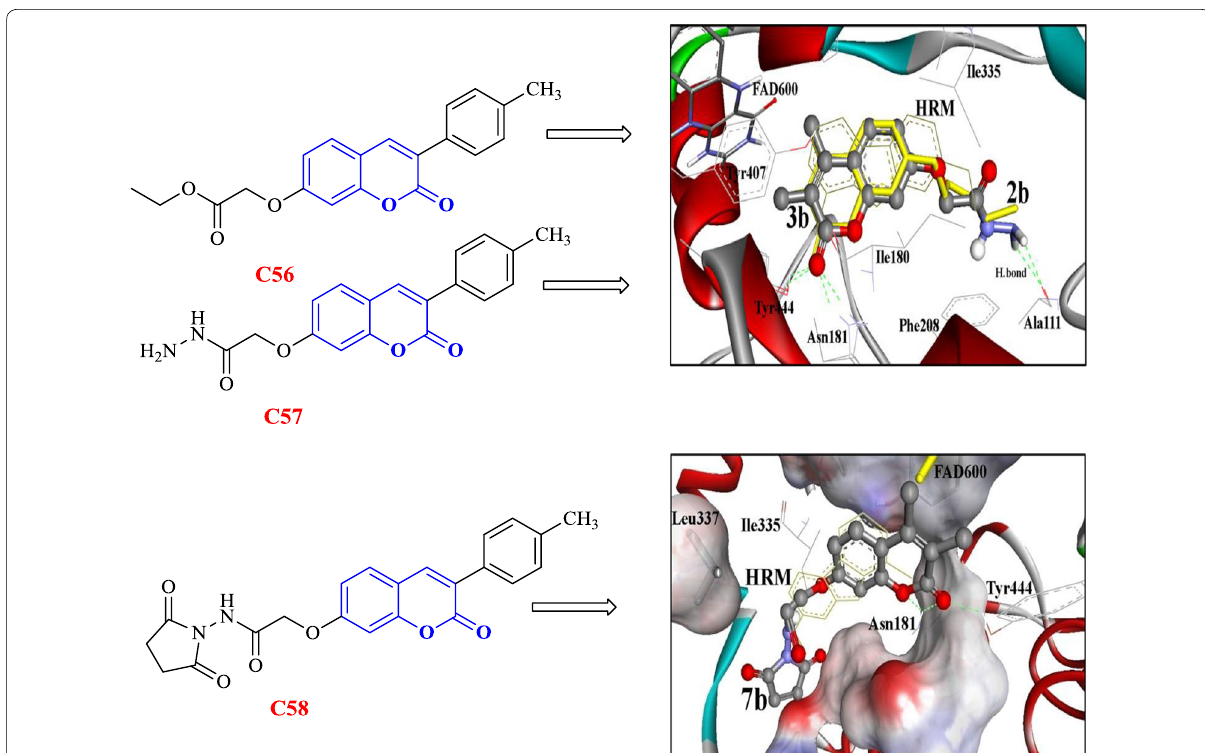
Fig. 59 Molecular structures and binding affinities of compound C56 (yellow stick) and C57 (ball and stick, coloured by element) and C58 into binding pocket of MAO-A (2Z5X)